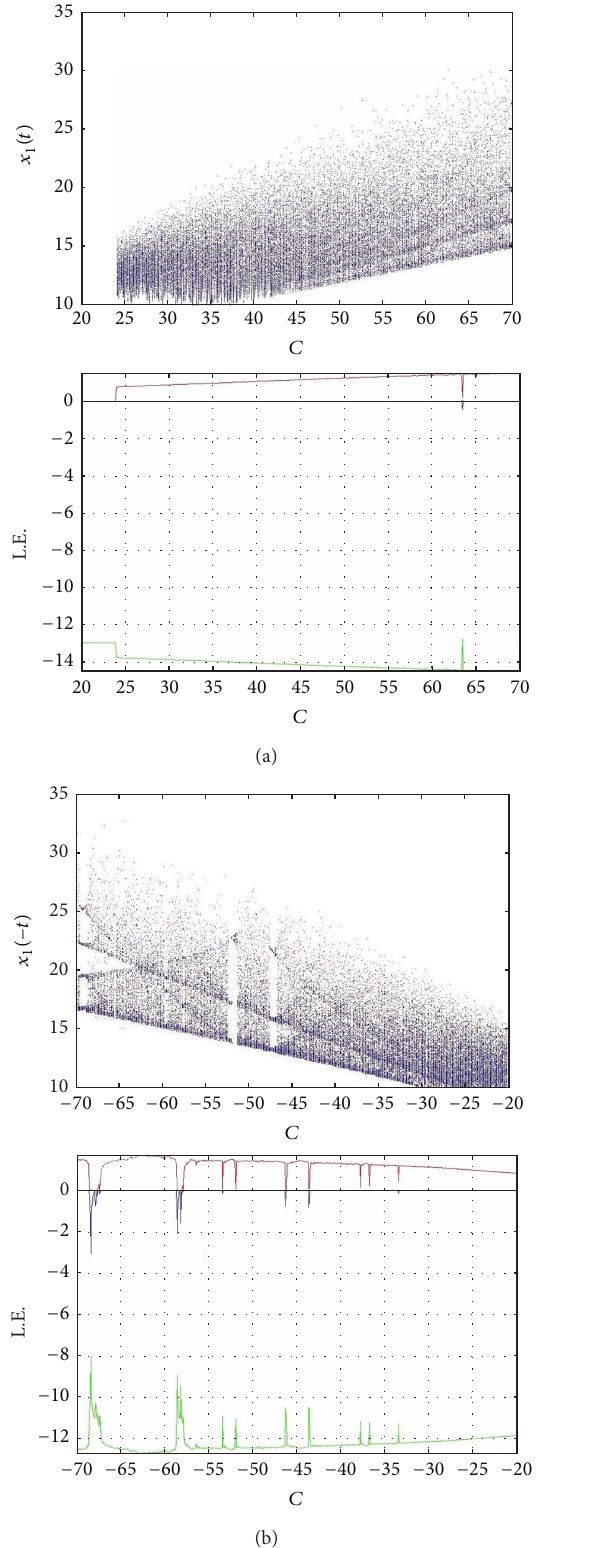
Figure 6: (a) Bifurcation diagram and Lyapunov exponents of chaotic classical Lorentz system with 𝑐 = 28 and 𝑎 = 10 . (b) Bifurcation diagram and Lyapunov exponents of chaotic time- reversed Lorentz system with 𝑐 = −28 and 𝑎 = −10 . The tables given previously show the different dynamic characters between classical and time-reversed Lorentz systems with different ranges of parameter 𝑏